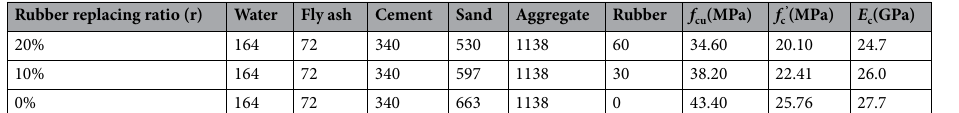
Rubber replacing ratio